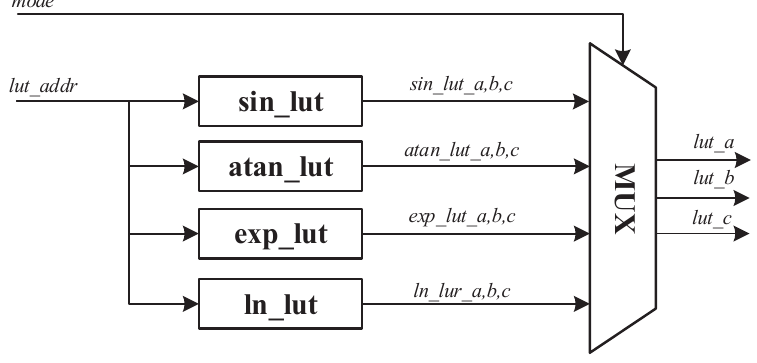
Figure 8. Lookup table module.